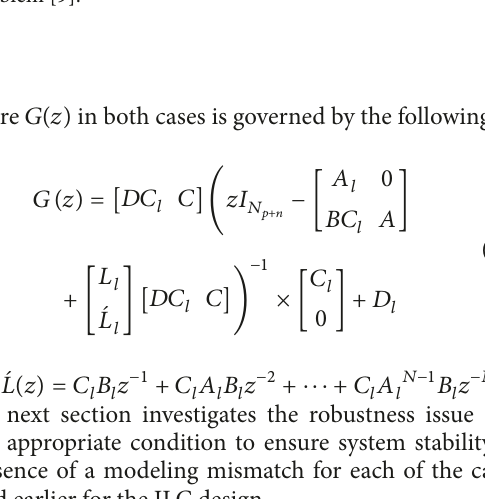
Figure 1: ILC as a feedback problem [9].